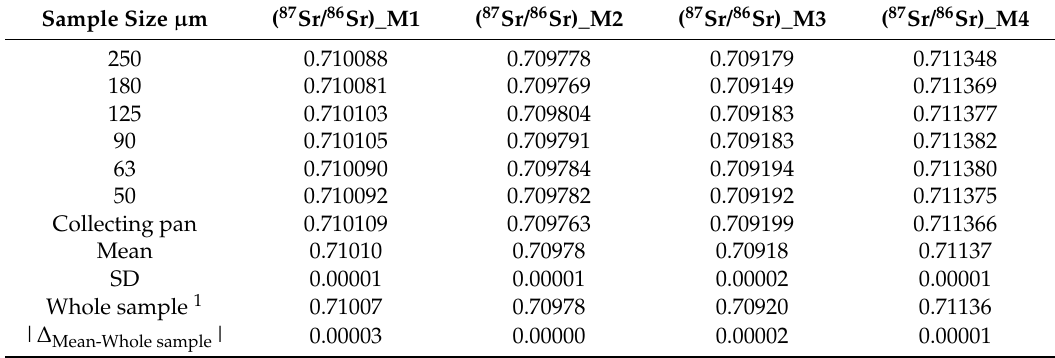
Table 2. Values of the 87 Sr/ 86 Sr isotope ratio determined on the soils processed by the planetary mill at different particle